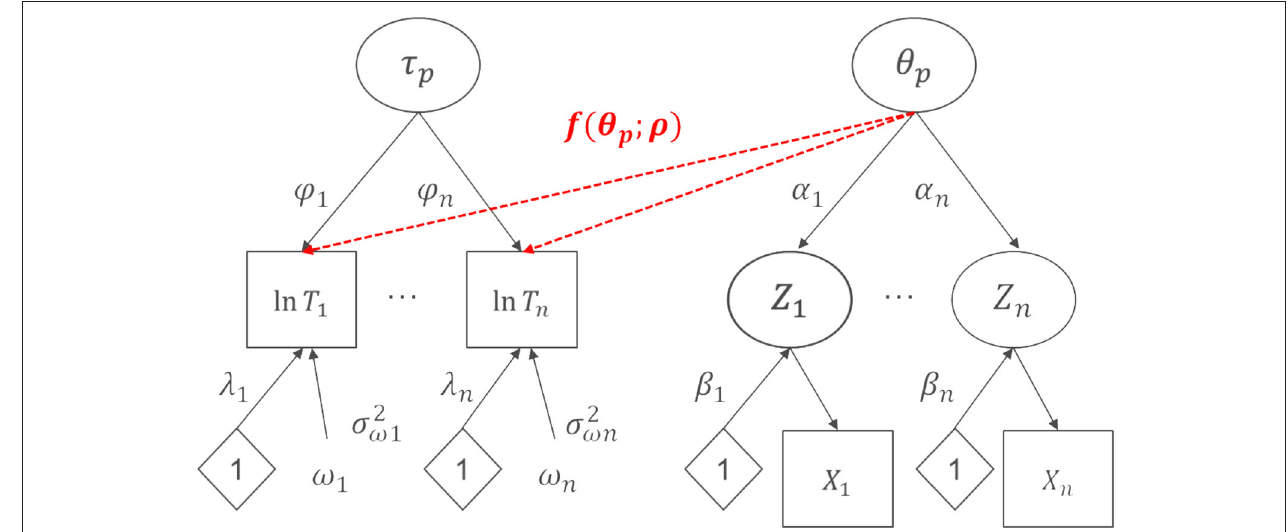
FIGURE 1 | Schematic display of the B-GLIRT Model by Molenaar et al. [1] used to investigate measurement invariance.